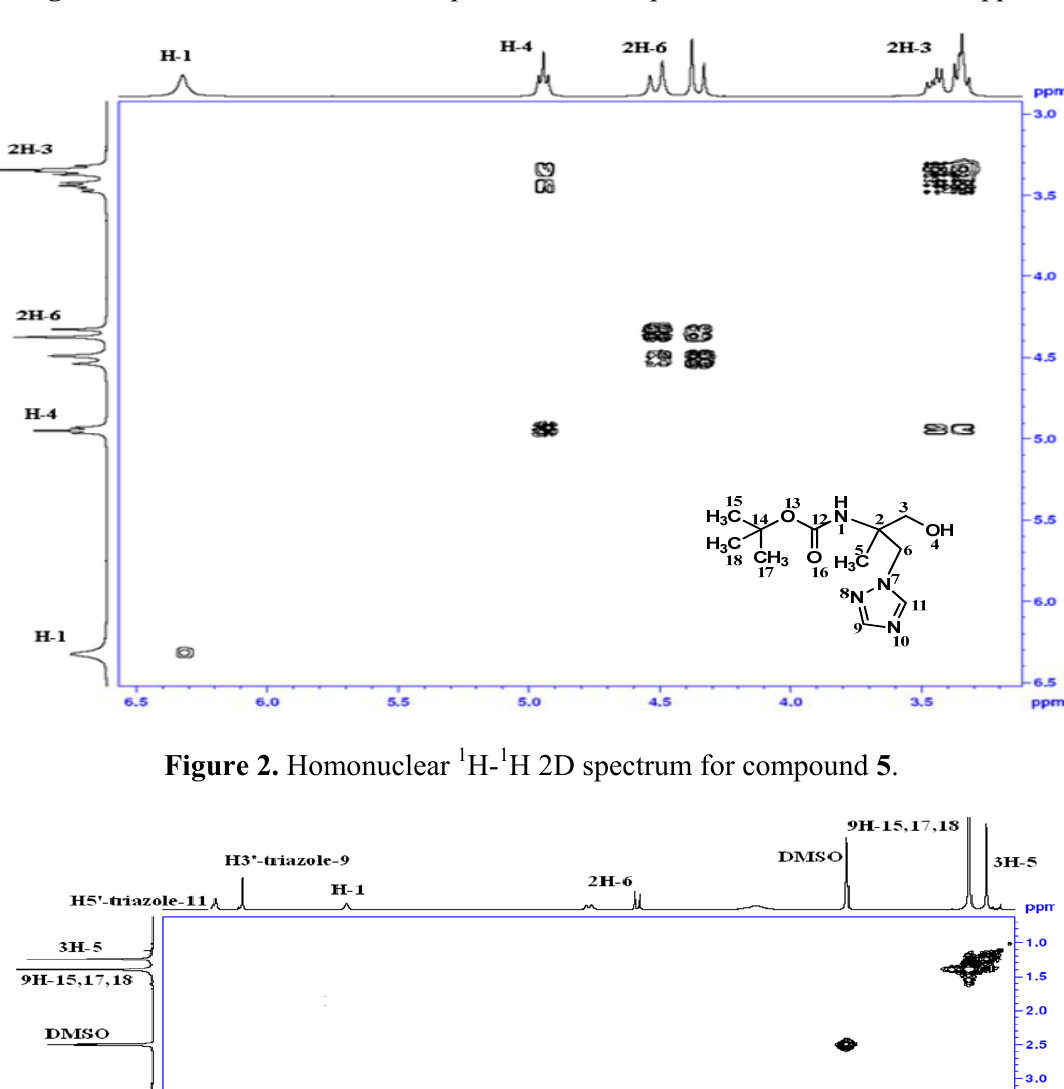
Figure 1. Homonuclear 1 H- 1 H 2D spectrum for compound 4 between 3 and 6.5 ppm.